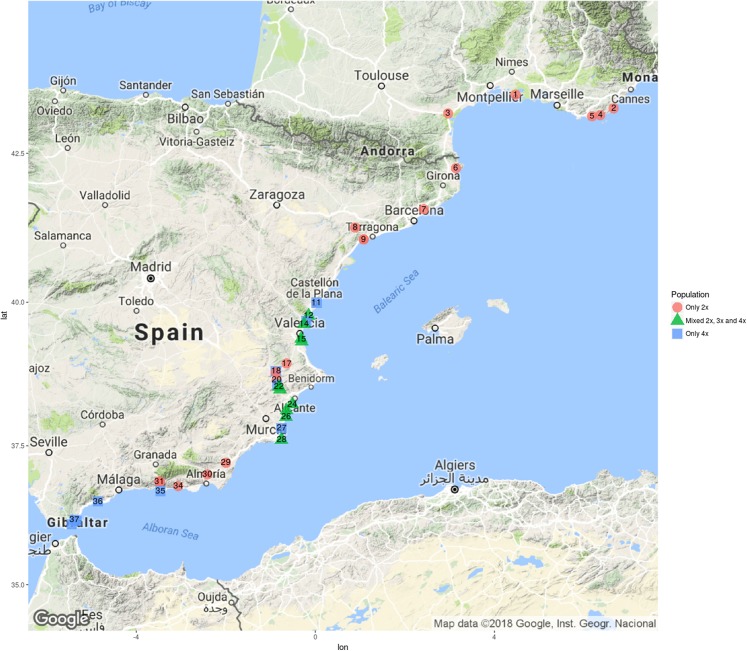
Localization of single-ploidy populations and mixed-ploidy populations in east and south Spain and in south France.Populations of diploid C. aspera are represented in red circles, populations of tetraploid C. seridis in blue squares, and mixed populations of C. aspera, C. seridis, and triploid C. x subdecurrens in green triangles. Numbers correspond to sites from Table 1. Map by Map Data ©2018 Google, Instituto Geográfico Nacional.